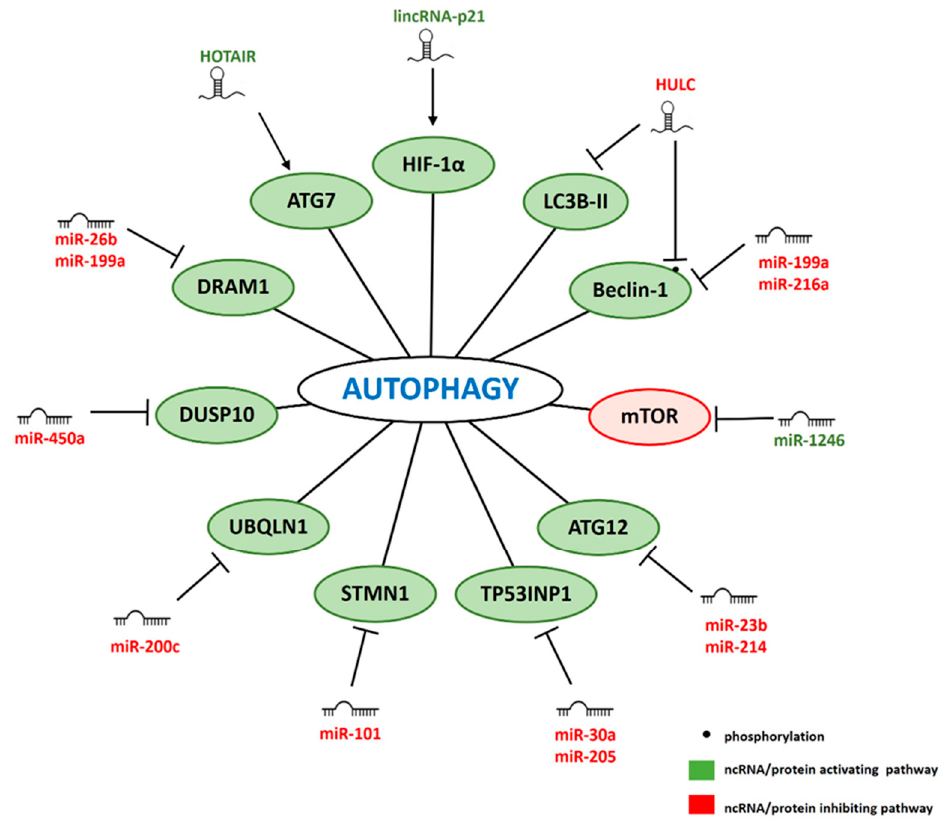
Figure 3. ncRNAs regulating IR-induced autophagy. ncRNAs and proteins promoting (green) or inhibiting (red) autophagy.